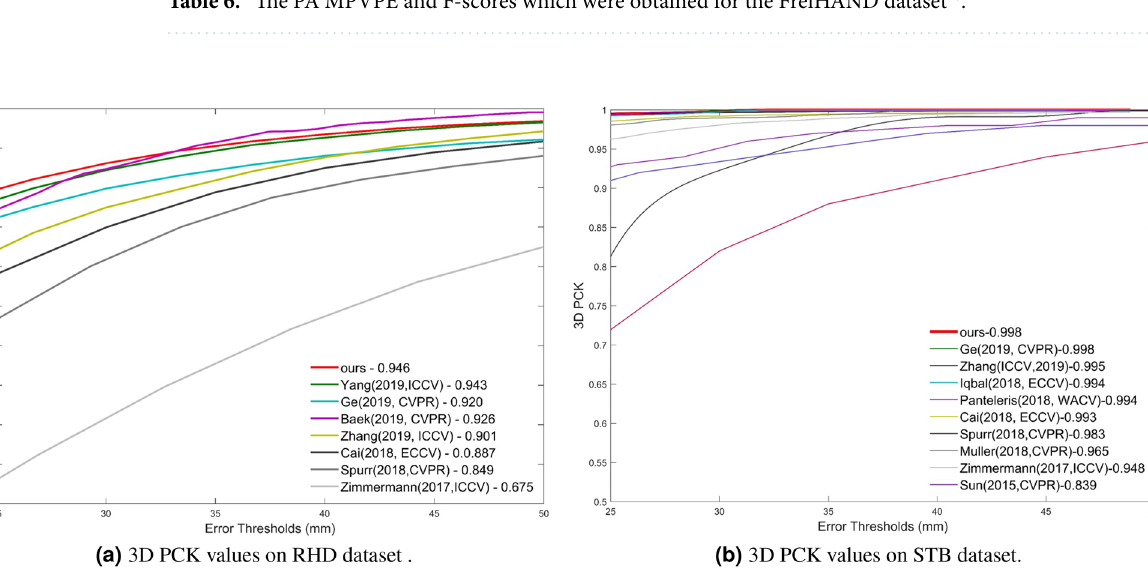
Table 6. The PA MPVPE and F-scores which were obtained for the FreiHAND dataset 16 .